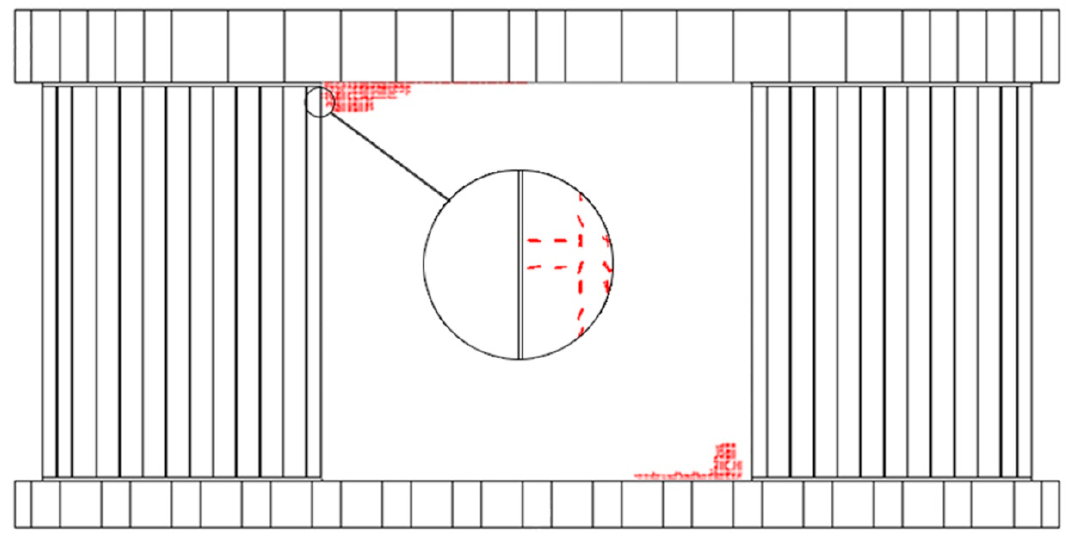
Figure 9. Diagram of specimen W2 in the simulation when the interface initially cracked and the horizontal displacement was 1.25 mm.